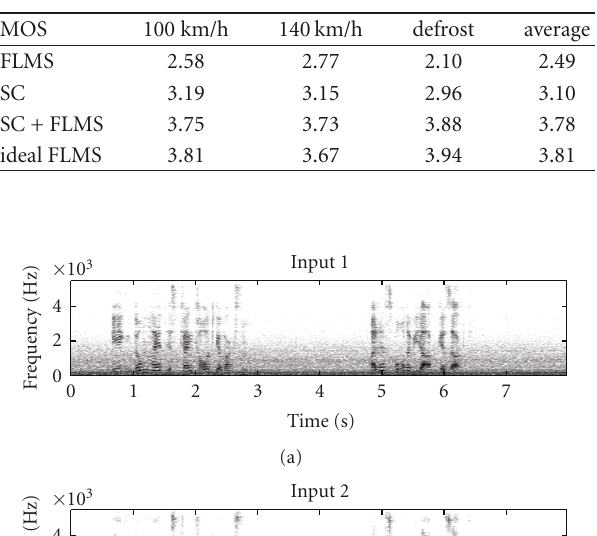
Table 5: Evaluation of the MOS-Test.